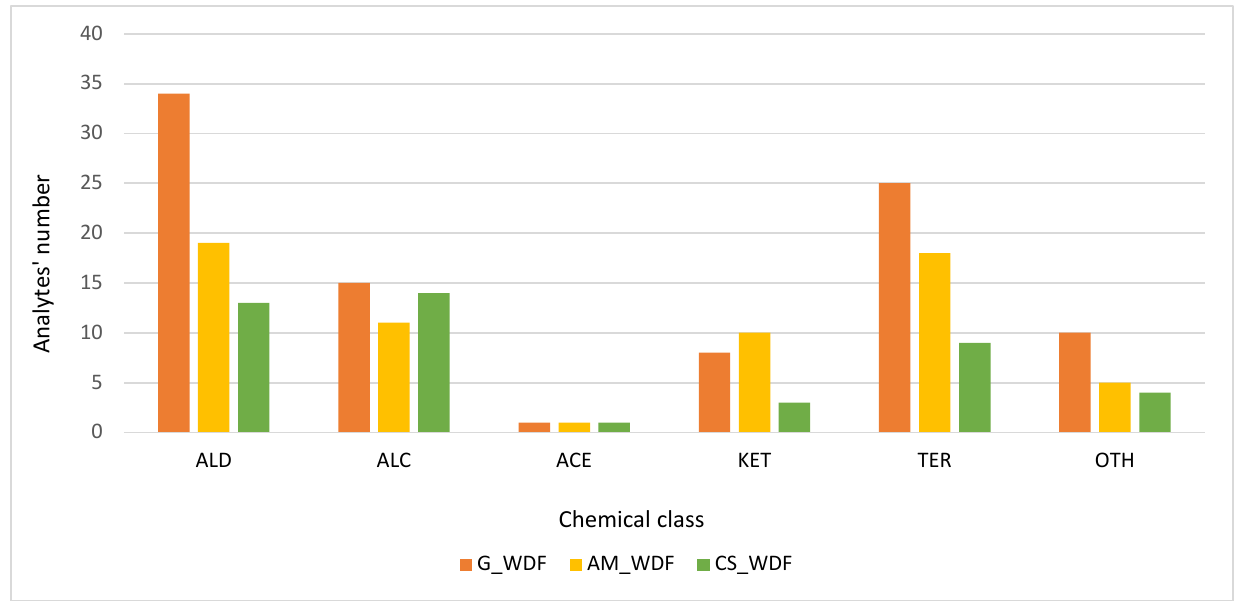
Figure 4. Histogram representation of the number of analytes by chemical class for each examined WDF sample. ALD (aldehydes), ALC (alcohols), ACE (acetate esters), KET (ketones), TER (terpenes and their derivatives), OTH (other analytes); G = Gavina ®® , AM = Asahi Myiako , CS = Crimson Sweet .